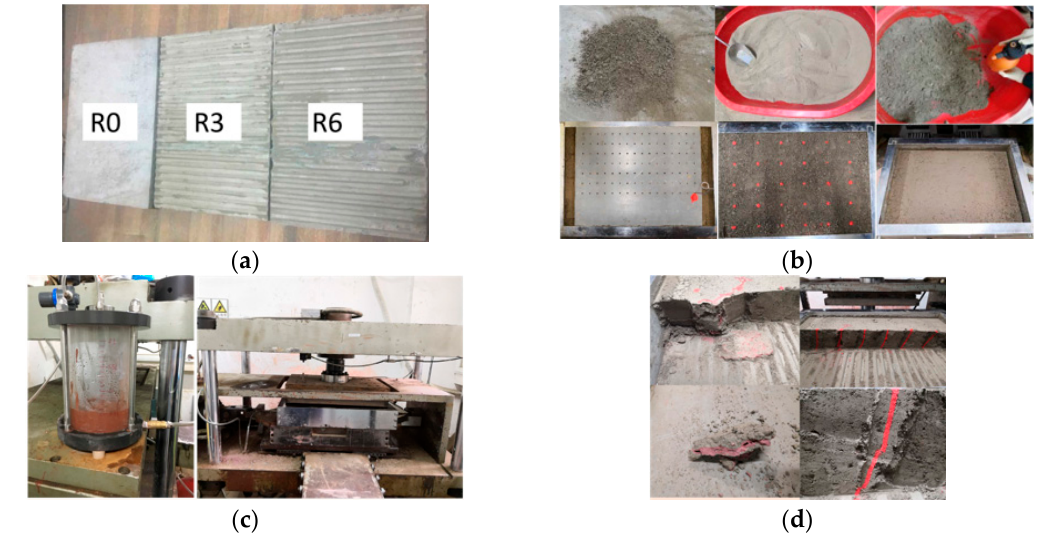
Figure 6. Main test procedures. ( a ) Concrete plate, ( b ) Soil, punching, colored bar, ( c ) Loading, consolidation, grouting, curing, and shearing, ( d ) Cutting, observation, and measurement.